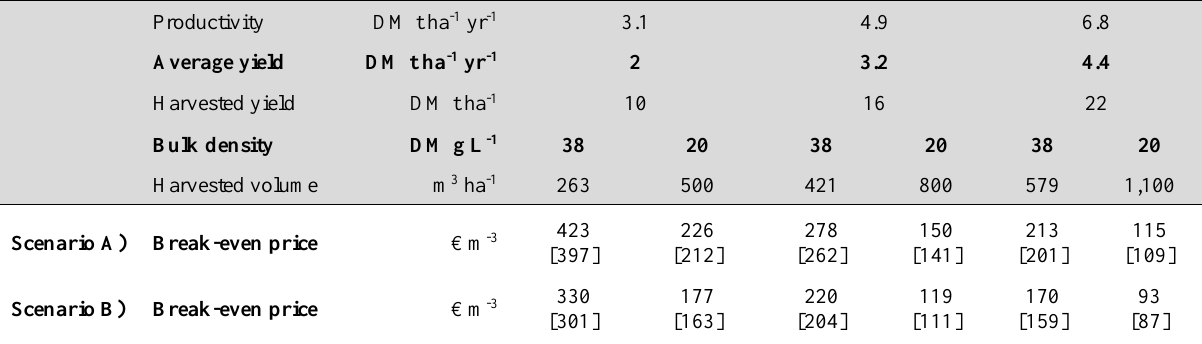
Table 2. Break-even price for Sphagnum farming at high cost (Scenario A) and medium cost (Scenario B) according to the harvested yield and bulk density. Prices in square brackets show the effect of an additional